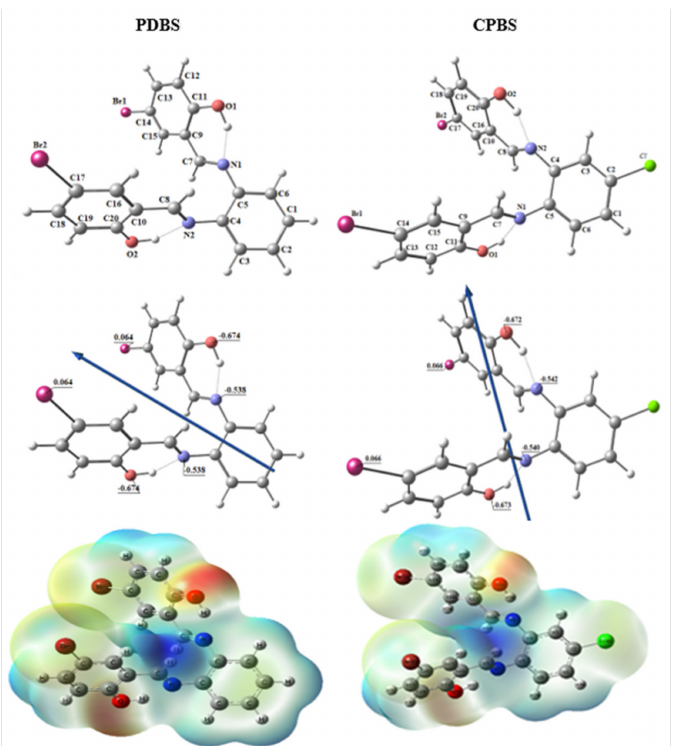
Figure 4. The natural charges on active centers of the optimized structures and molecular electrostatic potential (MEP) surface of ligands PDBS and CPBS by density function B3LYP/ 6-311g++(d,p).